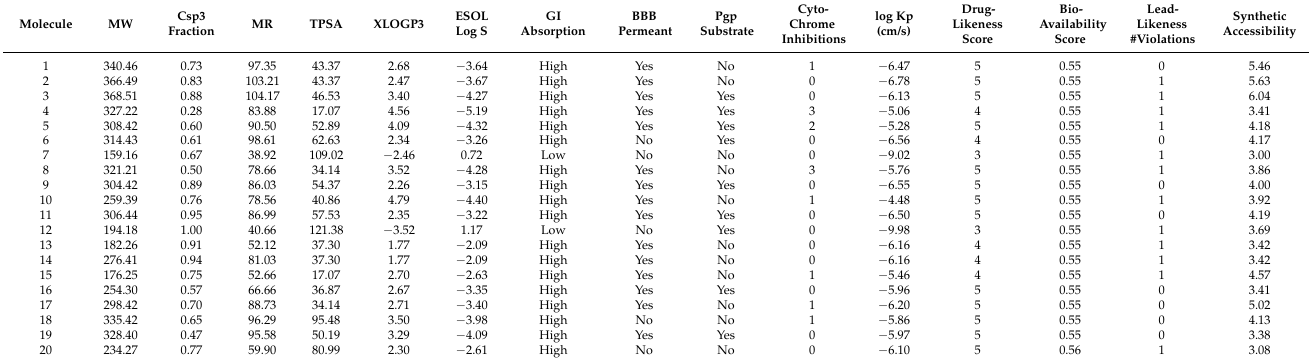
Table 3. Physicochemical properties as computed by SwissADME. Most columns are unmodified SwissADME columns, and in particular the BBB-permeant and Pgp (p-glycoprotein) substrate values are the same values as can be inspected from the BOILED-egg diagram. The “Drug-likeness Score” in this table is computed as the number of predictors that score positively for a certain molecule among: Lipinski, Ghose, Veber, Egan and Muegge. The “Cytochrome inhibitions” represents the number of Cytochrome P450 enzymes expected to be inhibited among CYP1A2, CYP2C19, CYP2C9, CYP2D6 and